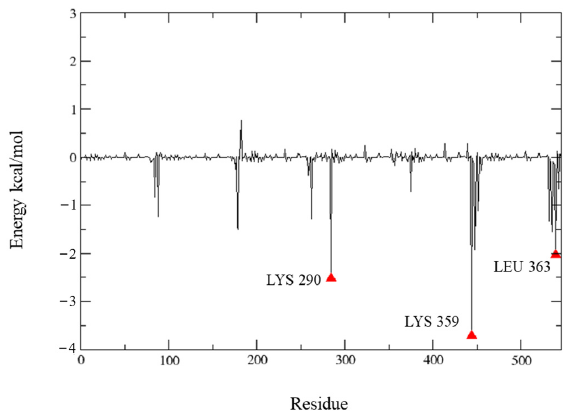
Figure 8. Residue decomposition analysis of CA-SP1 with DSC.